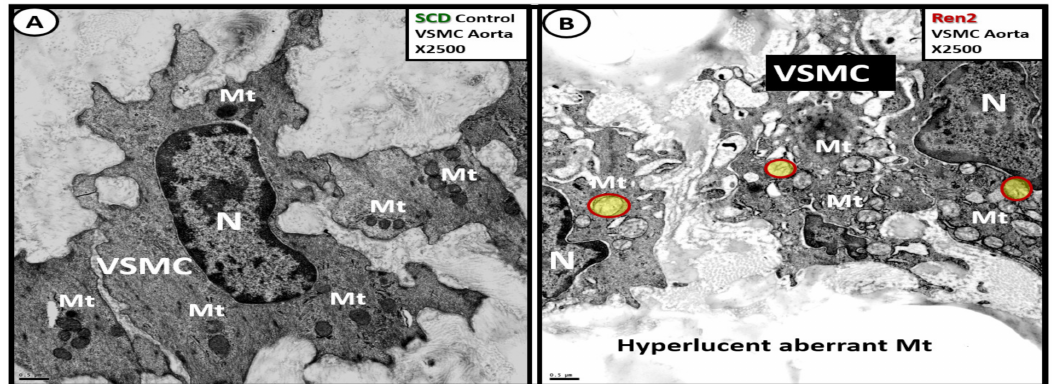
Figure 20. Aberrant mitochondria (aMt) were present in the 12-week-old male insulin resistant, impaired glucose tolerant, and hypertensive Ren2 rat model as compared to the Sprague Dawley controls (SDCs) in the descending thoracic aorta. Panel A demonstrates the normal morphology of the media vascular smooth muscle cell (VSMC) and note the normal appearance of the highly electron-dense mitochondria (Mt). Panel B depicts the hyperlucent aberrant Mt with loss of cristae and loss of the electron-dense Mt matrix (with some aMt pseudo-colored yellow with red outlines) in the Ren2 as compared to the SDC in panel A . These images are provided by permission from reference [66]. Magnification × 2500; scale bar = 0.5 µ m. N = nucleus